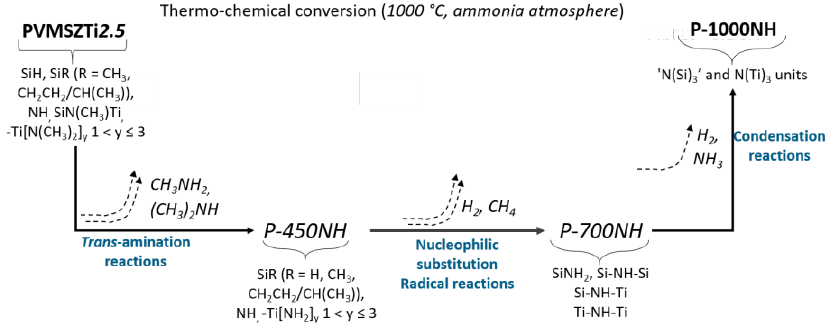
Figure 6. Schematic diagram of the thermo-chemical conversion of titanium-modified poly(vinylmethyl- co -methyl)silazanes into Si-Ti-N ceramics in flowing ammonia.